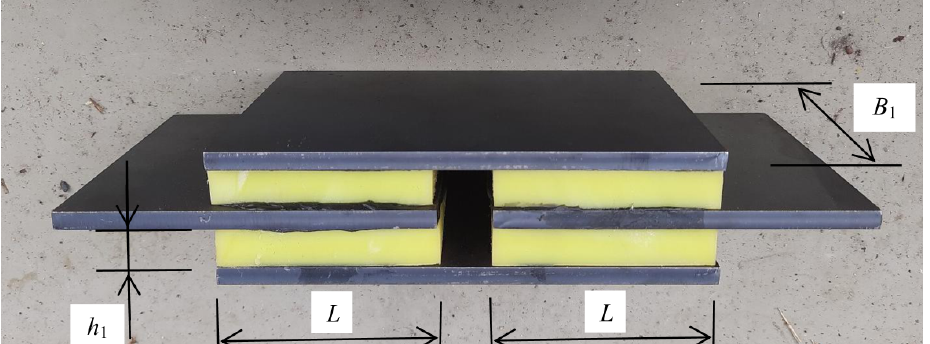
Figure 12. Layers of viscoelastic material glued to the steel plates.